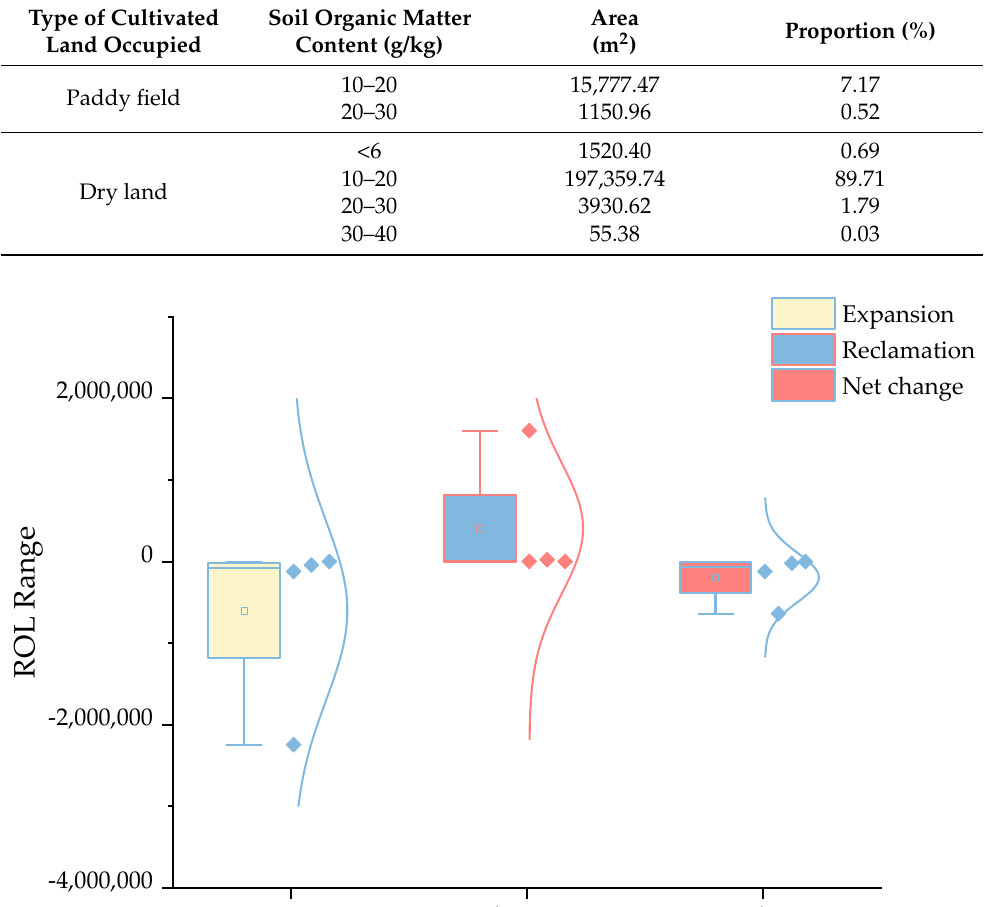
Table 3. Soil organic matter content of cultivated land occupied by the expansion of rural settlement.